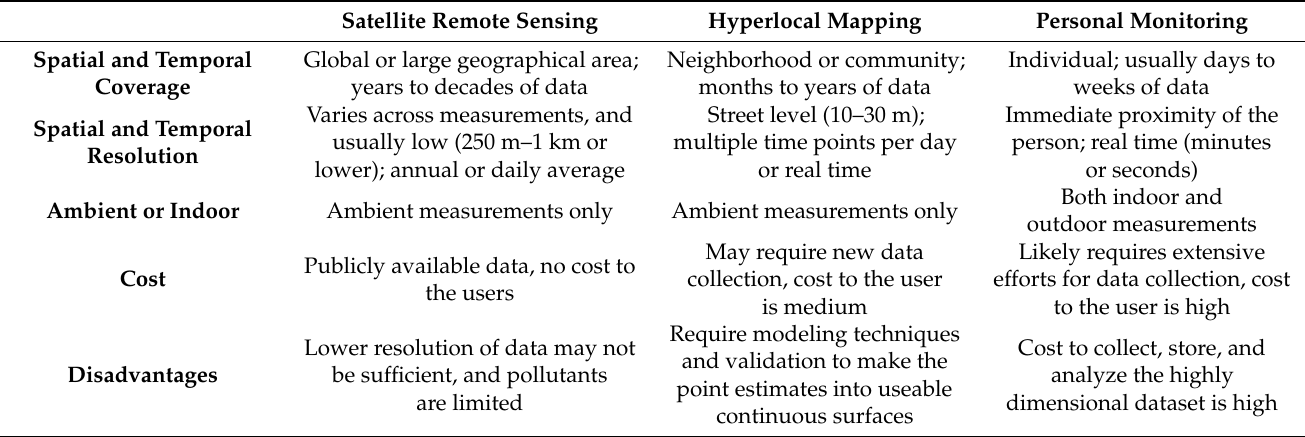
Table 1. Comparison of diverse geospatial technologies and data types discussed at the workshop (using air pollution (PM 2.5 , NO 2 , O 3 , etc.) as an example). Satellite Remote Sensing Hyperlocal Mapping Personal